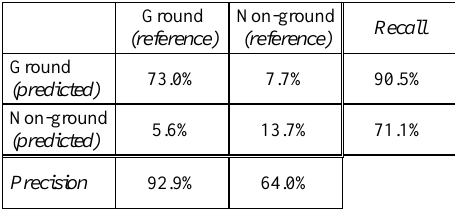
Table 2. Confusion matrix showing the percentage of classified points together with values of precision and recall for both classes.